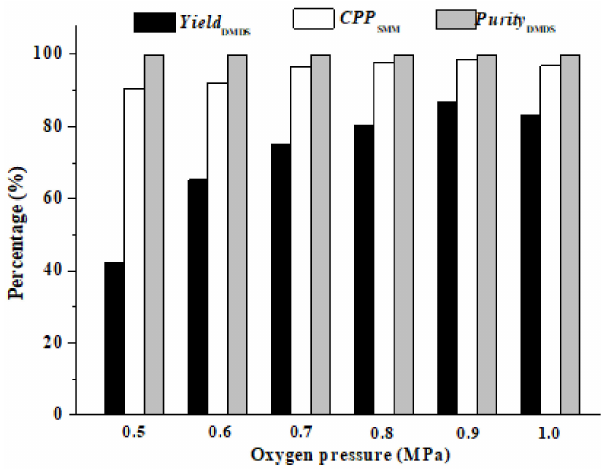
Figure 10. The effect of oxygen pressure on CPP SMM , Yield DMDS , and Purity DMDS using the AC-CoPcS catalyst. Experimental conditions: SMM (18.0 wt%) 450 g, RR = 600 r/min, C ca = 888.9 ppm, t = 60 min, T re = 65 ◦